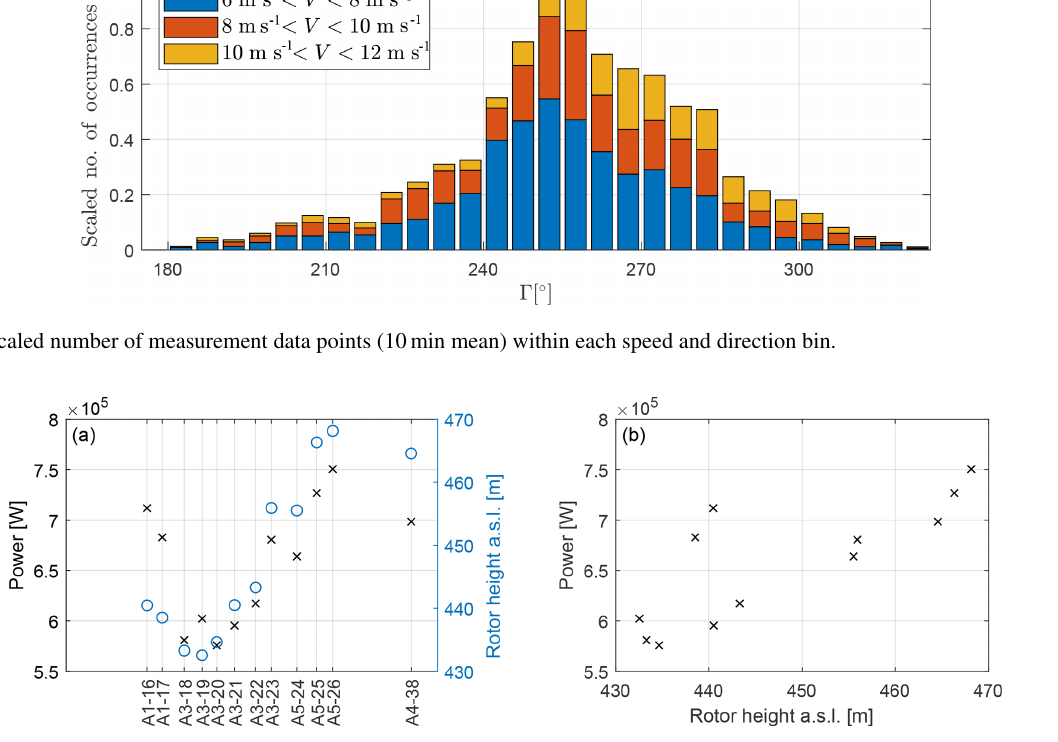
Figure 14. Correlation between power output and hub height with respect to SL. (a) Power ( × symbols and left y axis) and rotor height above SL ( ◦ symbols and right y axis) vs. lateral turbine position for a wind direction (cid:48) = 240 ◦ . (b) Power vs. rotor height above SL for (cid:48) ∈ [ 220 ◦ , 275 ◦ ] and V ∞ ∈ [ 8 , 10 ] ms − 1 . All conditions are free stream and all turbines of type GE1.5s.